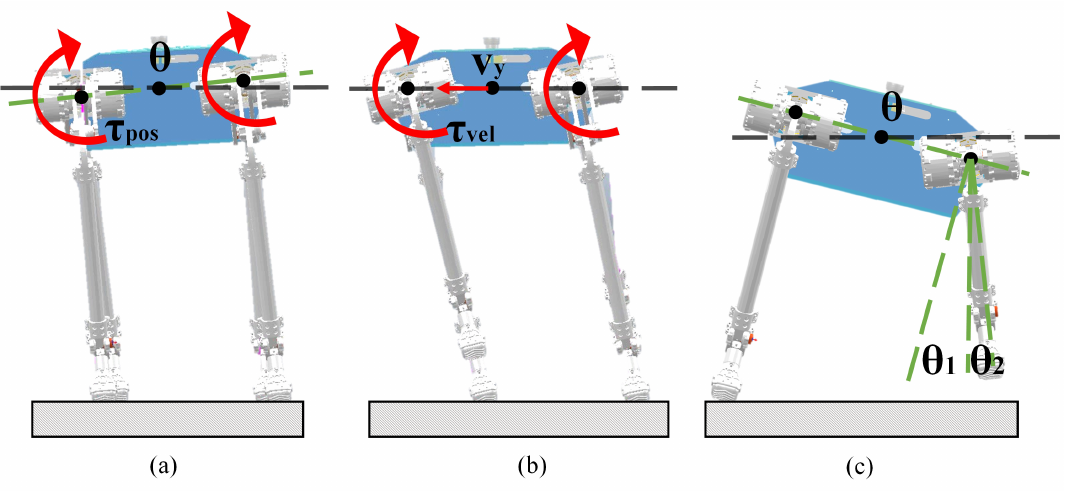
Figure 2. Compensation control diagram: ( a ) trunk posture compensation; ( b )trunk velocity compen- sation; ( c ) air swing leg